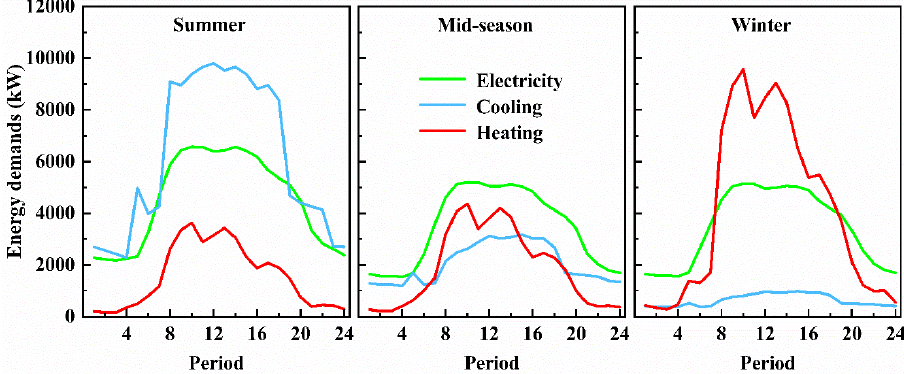
Figure 5. Load demands of the hospital during the three typical days.